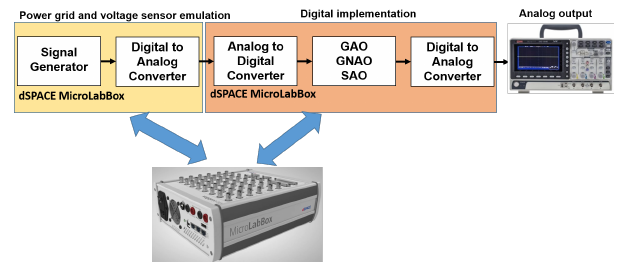
Figure 5. Experimental setup